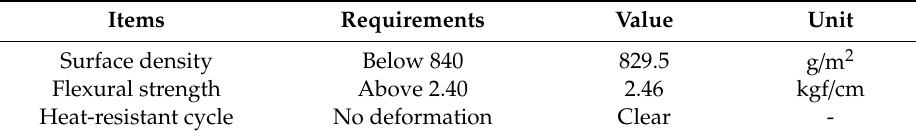
Table 3. Headlining insulation performance evaluation result.